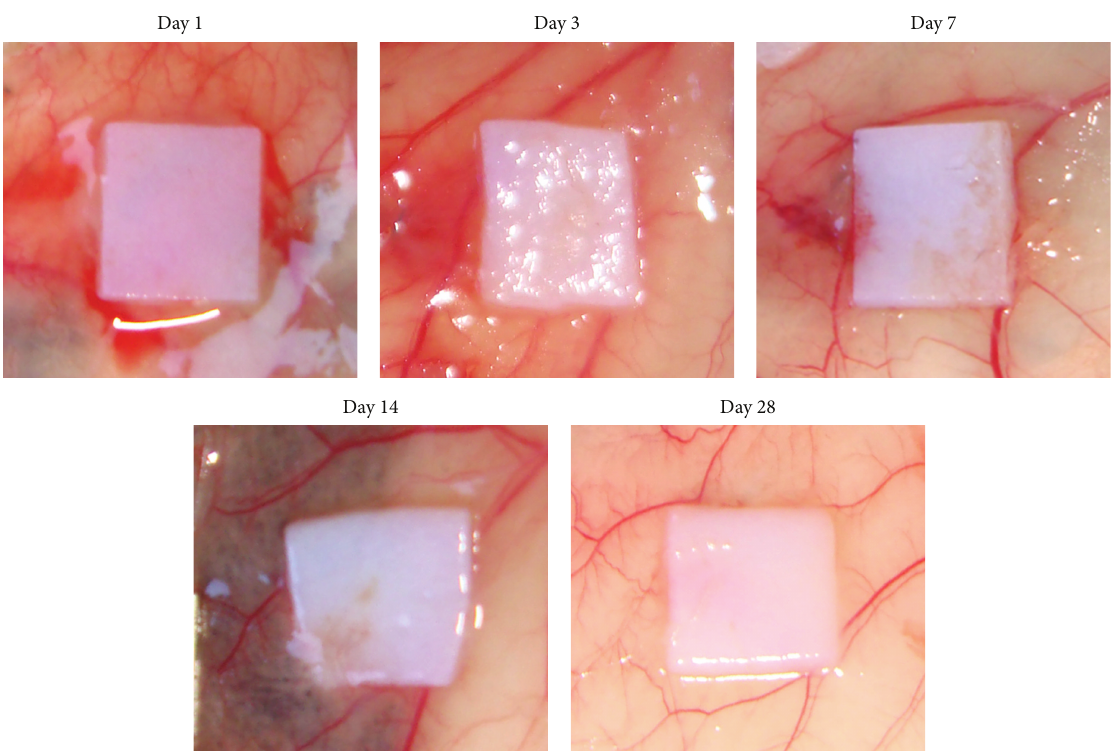
Figure 1: Gross photographs of PriMatrix implants at days 1, 3, 7, 14, and 28 following implantation. No inflammation or signs of rejection are observed; however, signs of implant resorption are indicative of a remodeling process.